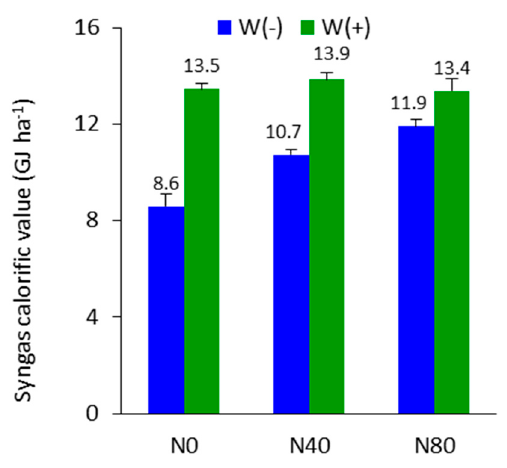
Figure 5. Calorific value of syngas obtained.